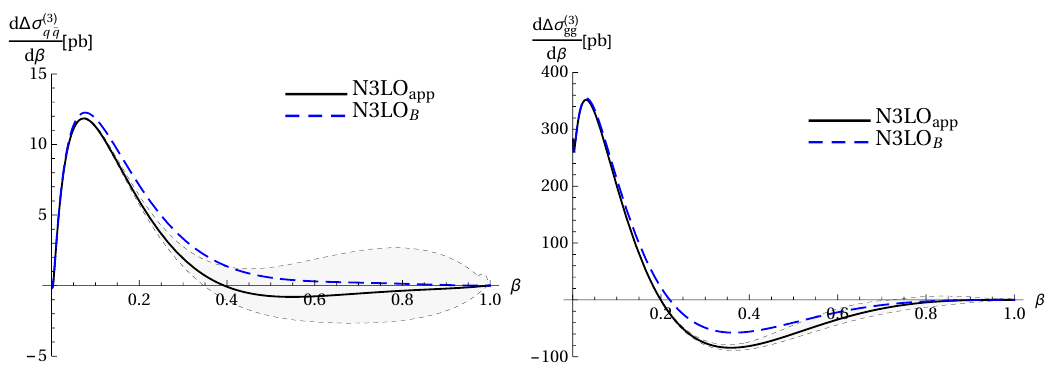
Figure 1 . Partonic N 3 LO corrections to the cross section for q (cid:22) q ! t (cid:22) t (left) and gg ! t (cid:22) t (right) p at the LHC ( s = 13 TeV), multiplied with the parton luminosities. Black (solid): N 3 LO app using (4.3), where the shaded gray area indicates the uncertainty estimated from varying the con- stants C (3) and by using the kinematic variable v instead of (cid:12) . Blue (long-dashed): N 3 LO B based pp 0 on NNLL